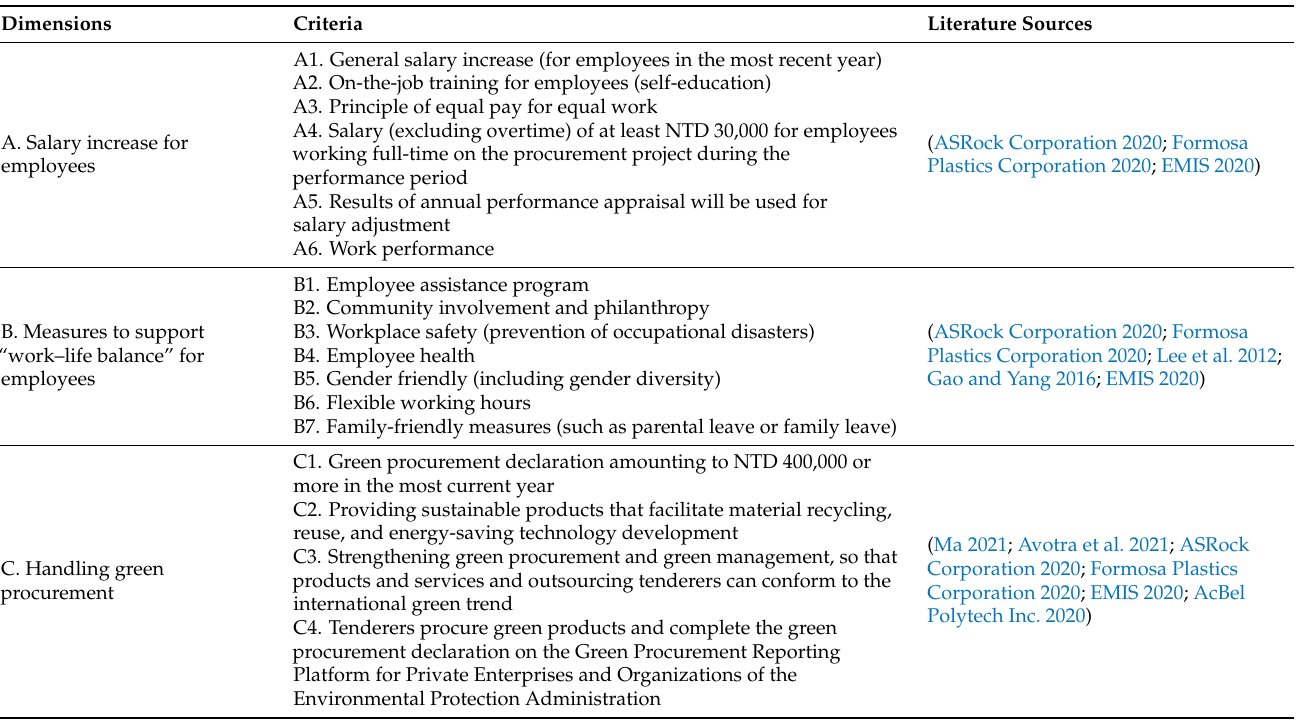
Table 10. Criteria for Prototyping Dimensions and Preliminary Framework.